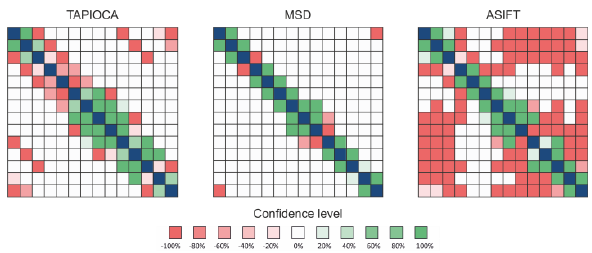
Figure 5. Images connection graphs of a single dataset for the result of all tie point detectors implemented in GRAPHOS.